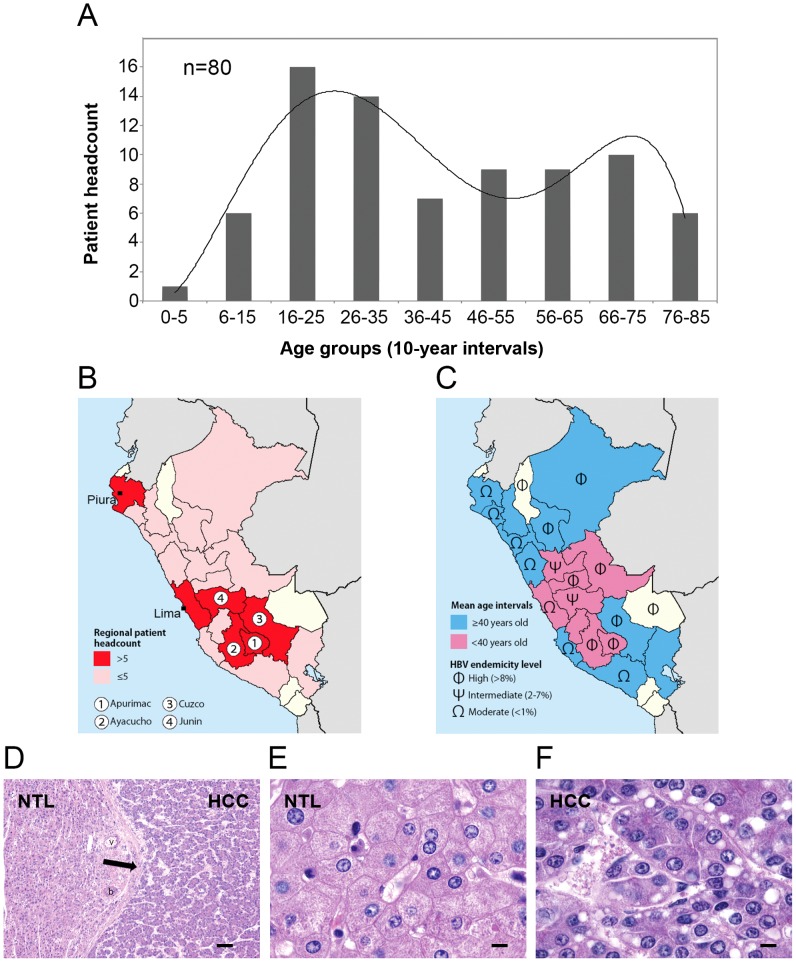
Occurrence of HCC in Peru presents an age-based clinico-epidemiological polarity.(A) Histogram presenting the distribution of the present patient population according to patients' age at the time of diagnosis. X-axis displays age (10-year bin); y-axis displays the headcount of patients for a given age group (n = 80). Straight line represents the histogram curve fitting with a Gaussian mixture function (BI = 1.8). This bimodal distribution concurs with the observation previously made in Peru [6]. (B,C) Distribution maps of the population size (B) and mean age (C) of the patients according to their regional origin. (B) Regions for which patient headcount was ≤5 and>5 are choropleth mapped in pink and red, respectively. The southern-central Andean area encompassing the regions of Apurimac (#1), Ayacucho (#2), Cuzco (#3), and Junin (#4) is the area from where was originating the larger subset of <40 patients. (C) Regions for which mean age was <40 and ≥40 years old are choropleth mapped in magenta and blue, respectively. Φ indicates highly endemic regions of HBV infection (>8%); Ψ indicates regions of intermediate endemicity (2-7%); Ω indicates regions of moderate endemicity (<1%), as described [14]. (B,C) Regions for which headcount was null are choropleth mapped in off-white. (D–F) Hematoxylin–eosin-stained liver sections from a 37-year-old Peruvian female individual with an 18-cm-diameter multinodular, moderately differentiated HCC. (D) Both NTL (left) and HCC (right) tissues presented under low magnification (40x). The arrow indicates the fibrotic tissues of the capsule enclosing HCC nodules. b: bile duct; v: vein. Scale bar; 100 µm. (E) Presentation of the normal NTL tissue under high magnification (100x). (F) Presentation of the E.S.2 HCC tissue with a trabecular pattern under high magnification (100x). (E,F) Scale bars; 10 µm.